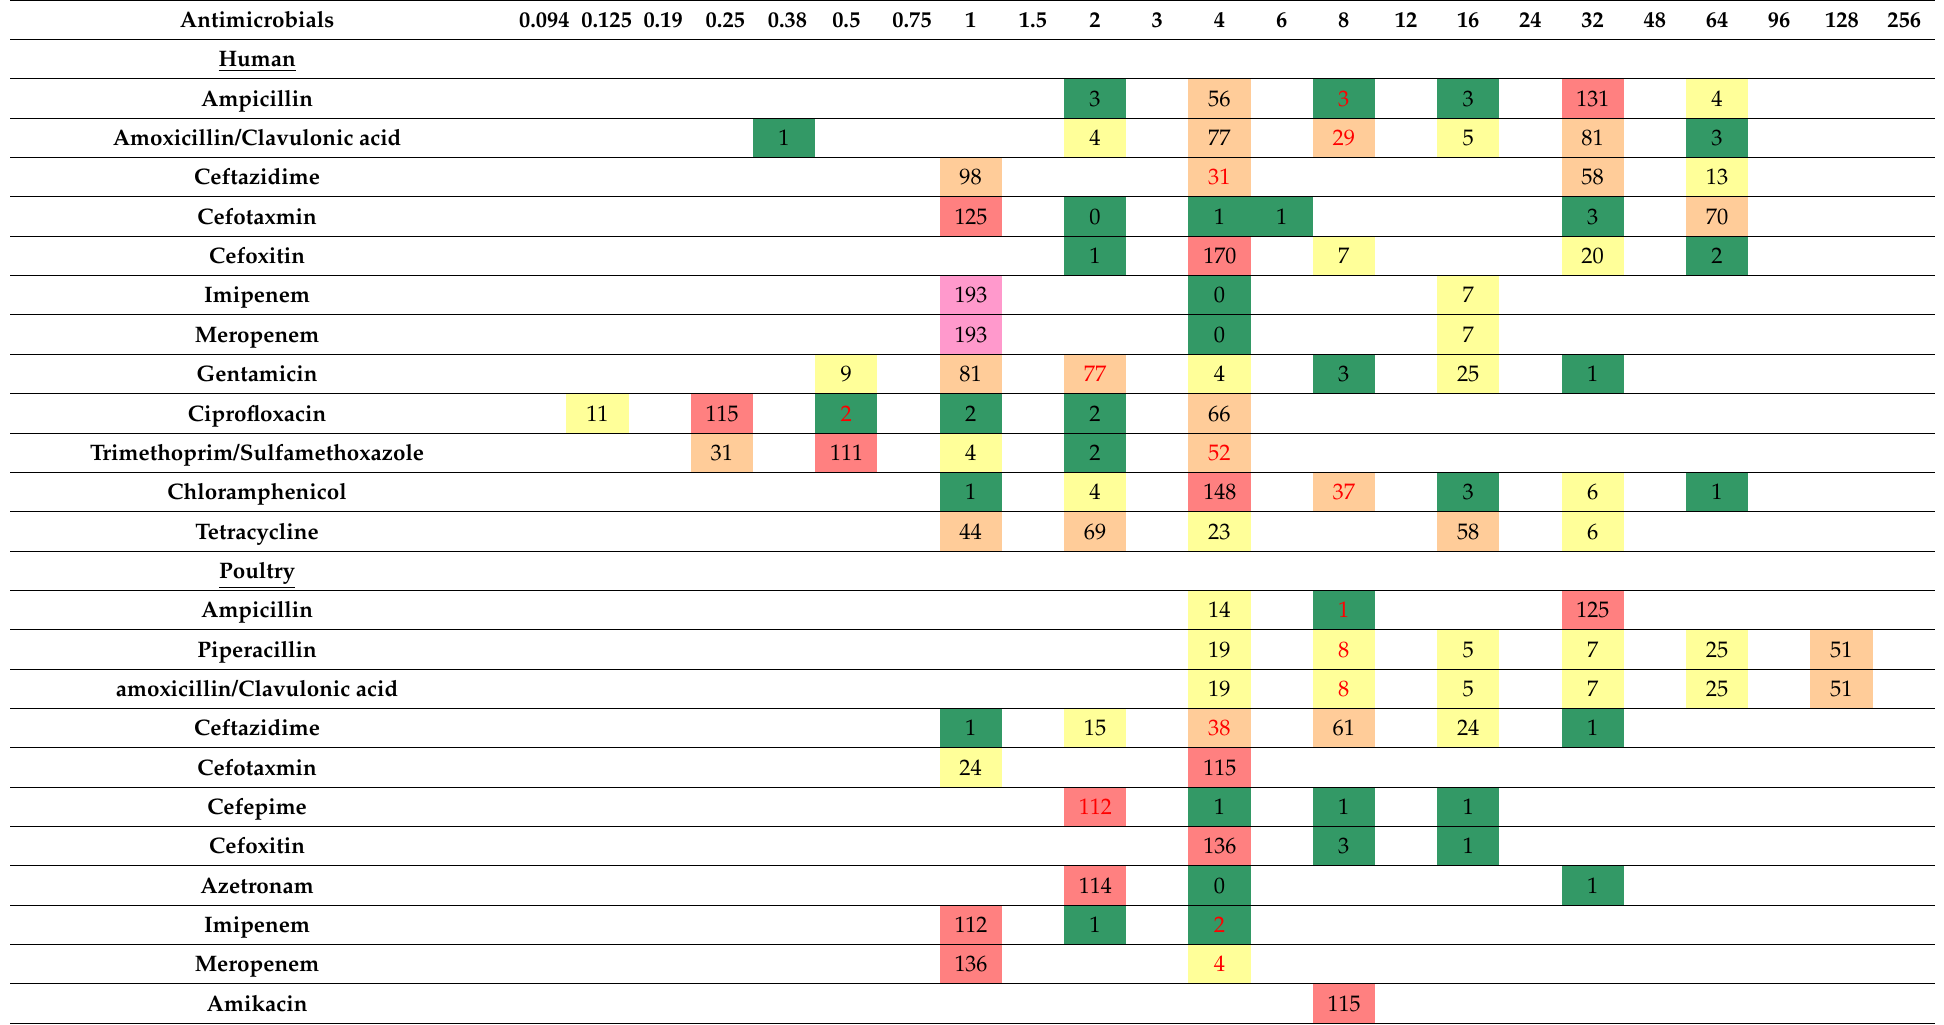
Table 2. Heat map of MIC distribution of E. coli among humans, poultry, and aquaculture (Phoenix PX 2830).